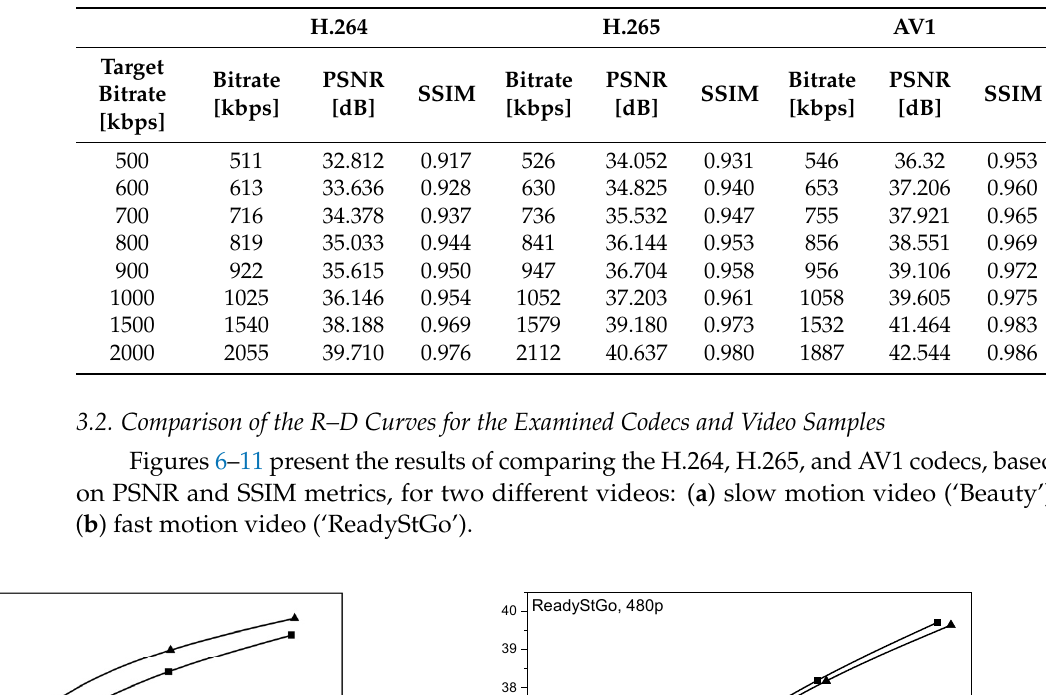
Table 4. PSNR and SSIM results for the ‘ReadyStGo’ video test samples.